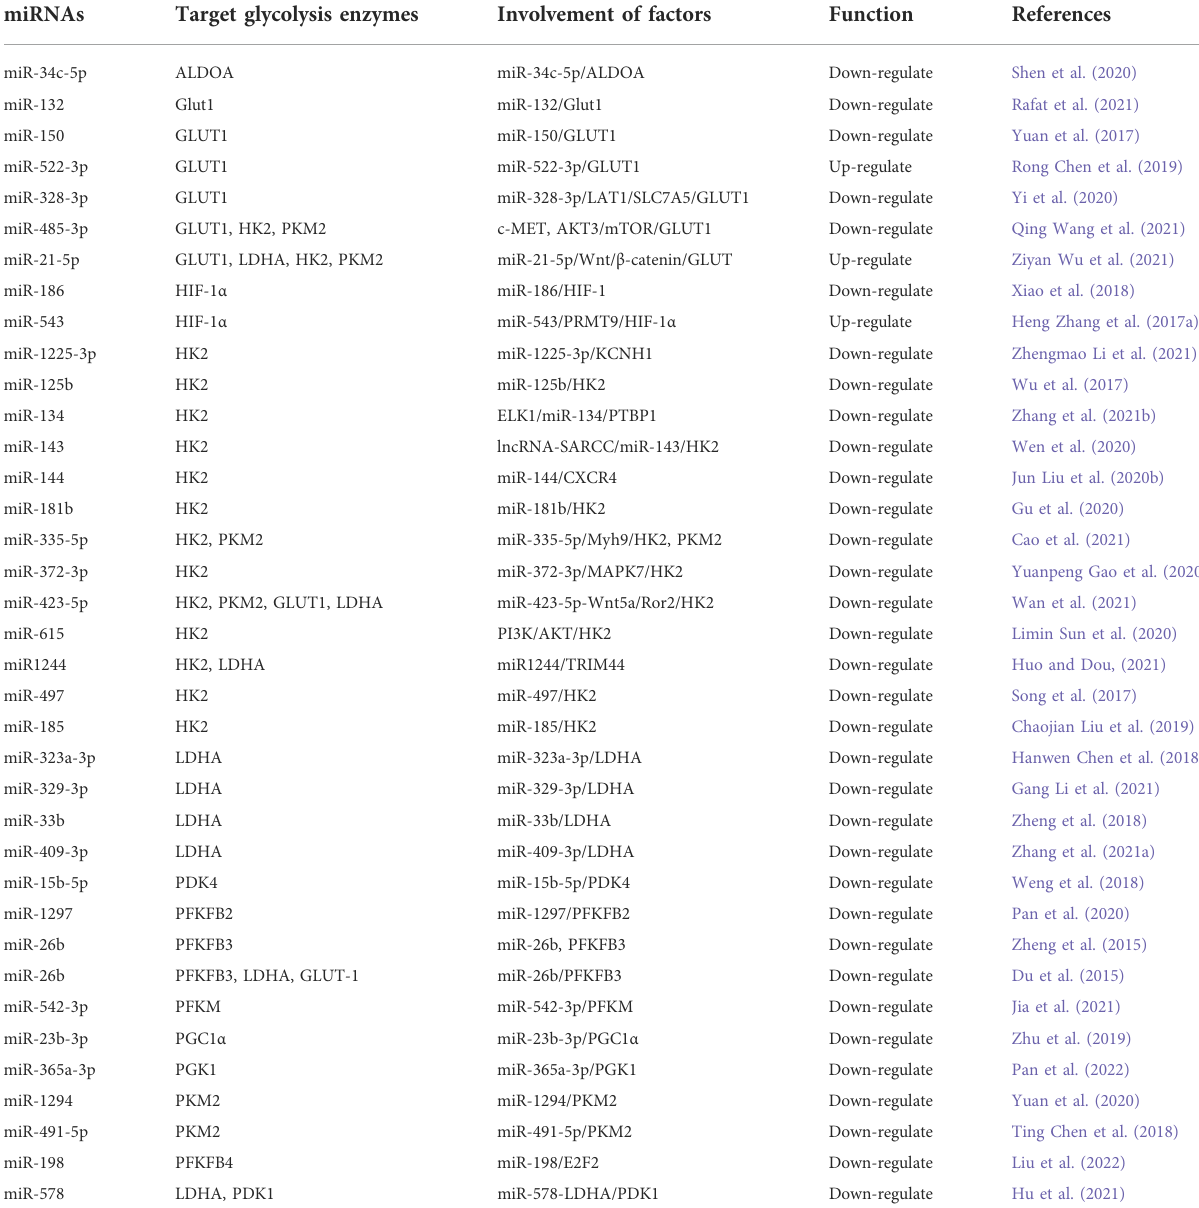
TABLE 3 miRNAs regulate glycolysis enzymes in osteosarcoma. miRNAs Target glycolysis enzymes Involvement of factors